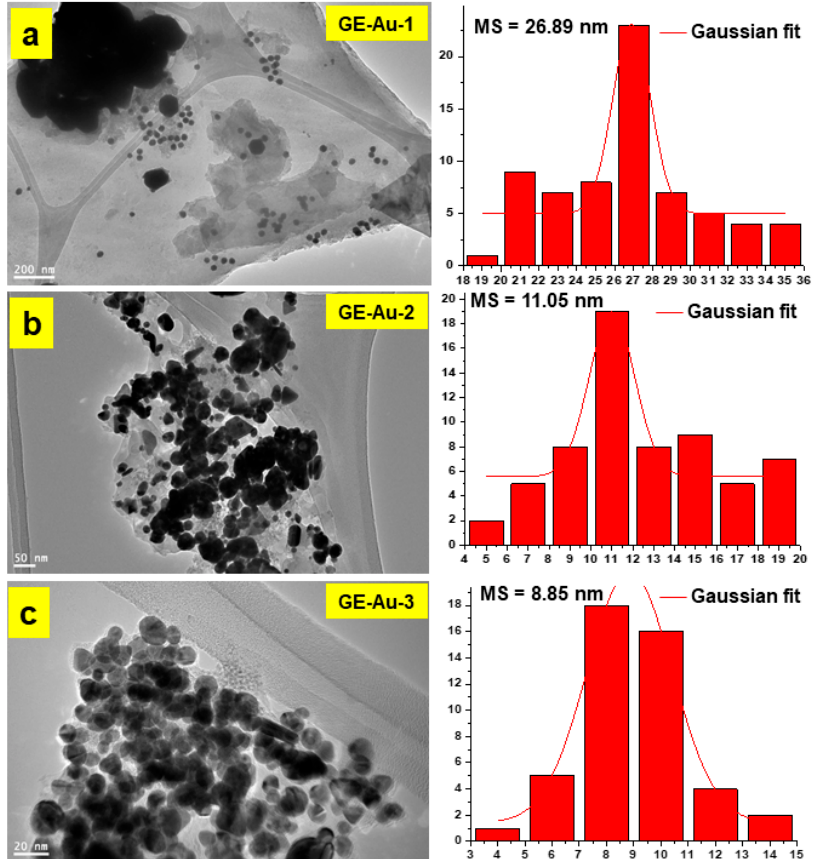
Figure 3. TEM images of Au NPs prepared by using different concentrations of GE extract, ( a ) Au NPs prepared by using 5 mL of GE and their size distribution, ( b ) NPs obtained by using 10 mL GE, and ( c ) Au NPs obtained by using 20 mL of GE extract and their size distribution. * MS = Mean Size, red line represents Gaussian fit.